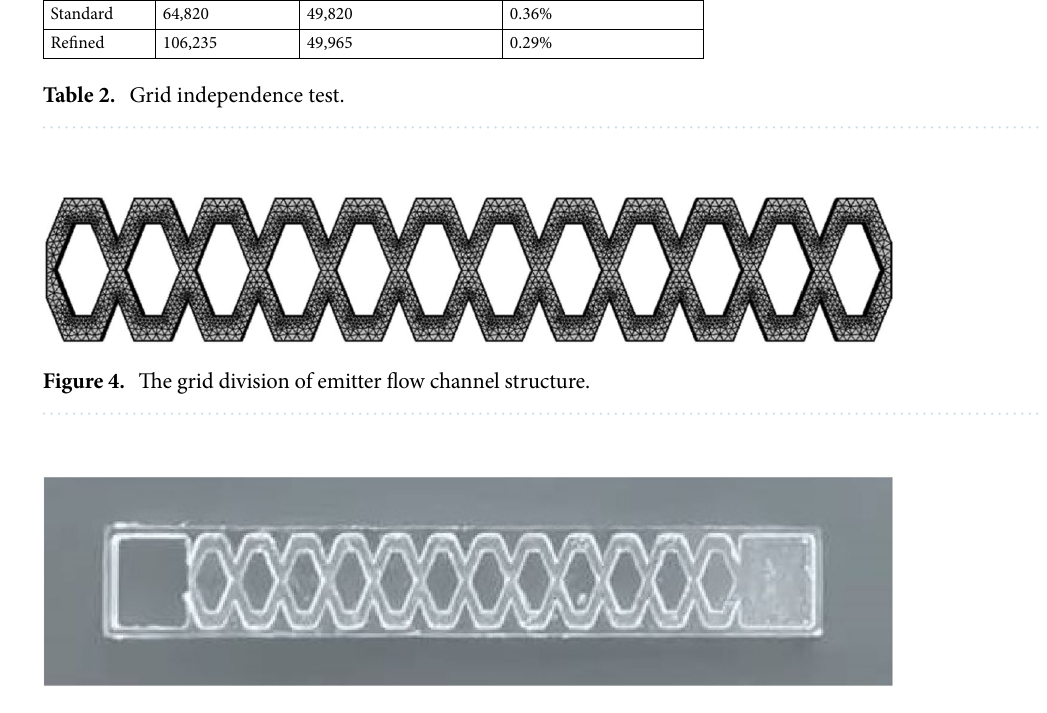
Figure 5. Physical drawing of the pit flow channel drip irrigation emitter.